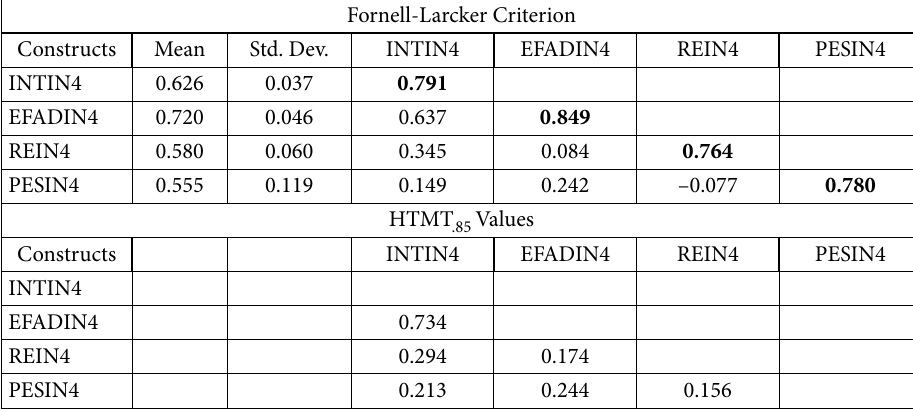
Table 10. Fornell-Larcker criterion and HTMT .85